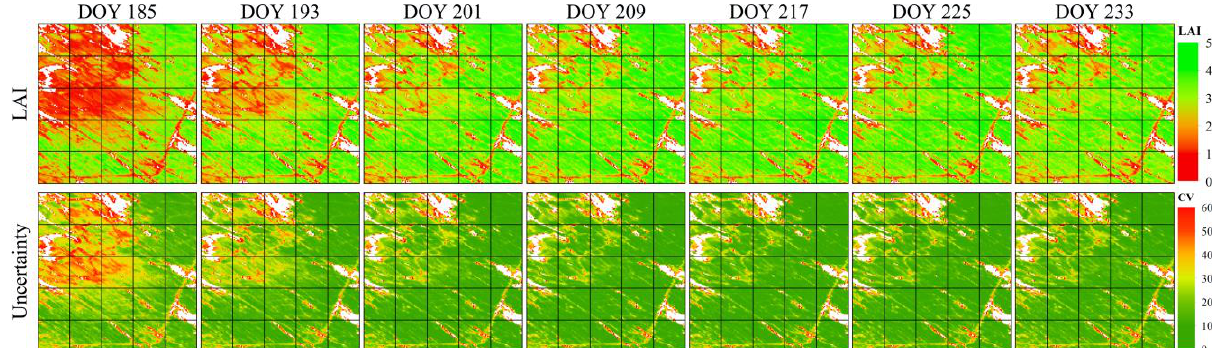
Figure 4. High spatial resolution LAI maps and the corresponding quality evaluation results. The quality of each pixel is represented by its CV. Both LAI and CV were generated from the GPR model using LAINet measured LAI and CACAO reconstructed NDVI. The white parts represent non-vegetation land cover types.